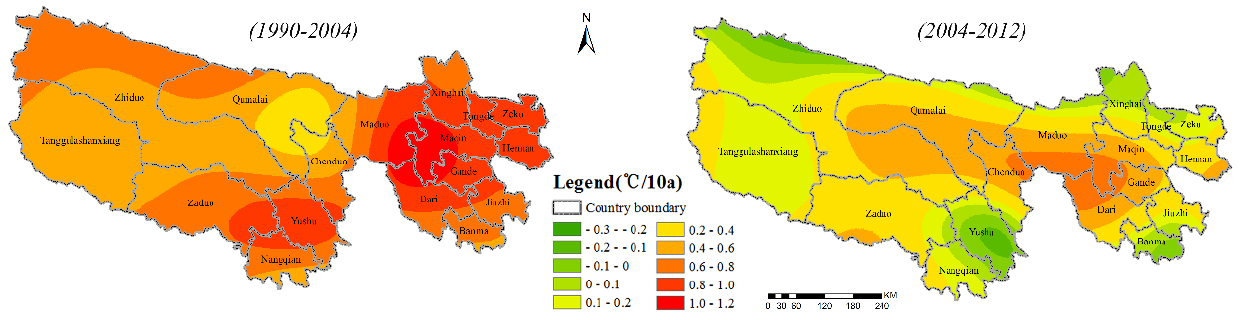
Figure 7. Spatial distribution of annual average temperature tendency rate in the TRH region.